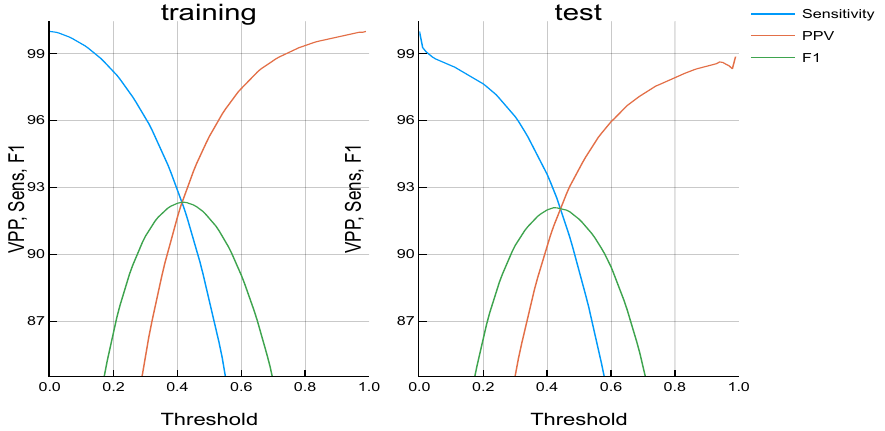
Figure 2. Sensitivity, Predictive Positive Value (VPP) and F1 score for the different threshold in the selected